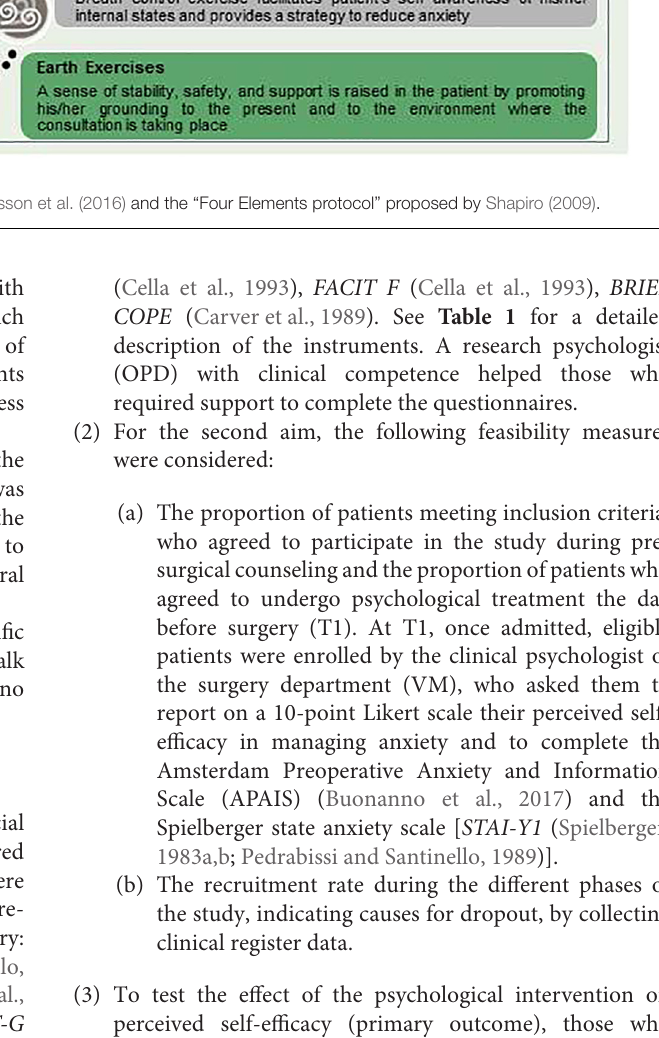
FIGURE 1 | Description of the psychological intervention adapted from Svensson et al. (2016) and the “Four Elements protocol” proposed by Shapiro (2009).